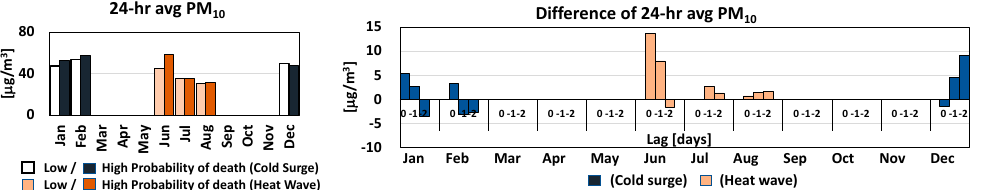
and the differences in PM 10 (PM 10 (high probability of death) – PM 10 (low probability of death) ) from zero to two days 290 PM 10 (PM 10 (high probability of death) –PM 10 (low probability of death) ) from zero to two days before death. Monthly average PM 2.5 levels on H days were higher than those on L days except in before death. (a) is when cold surges or heat waves did not occur, and (b) is when cold surges or heat 291